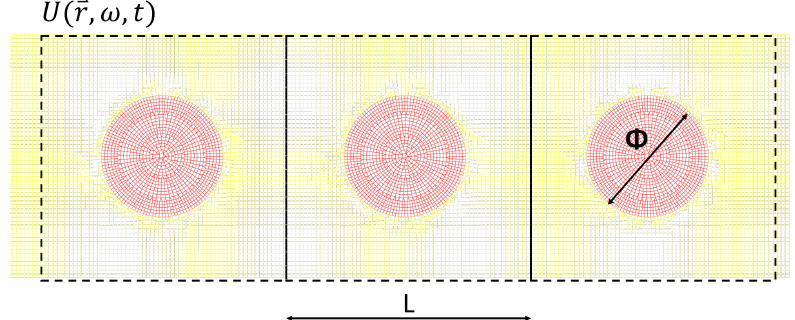
Figure 3. Schematic illustration of the central part of the sample for L = 60 Å: in yellow represents the matrix material, in red the inclusions. Periodic reproduction of this sample along the vertical direction is assured by periodic boundary